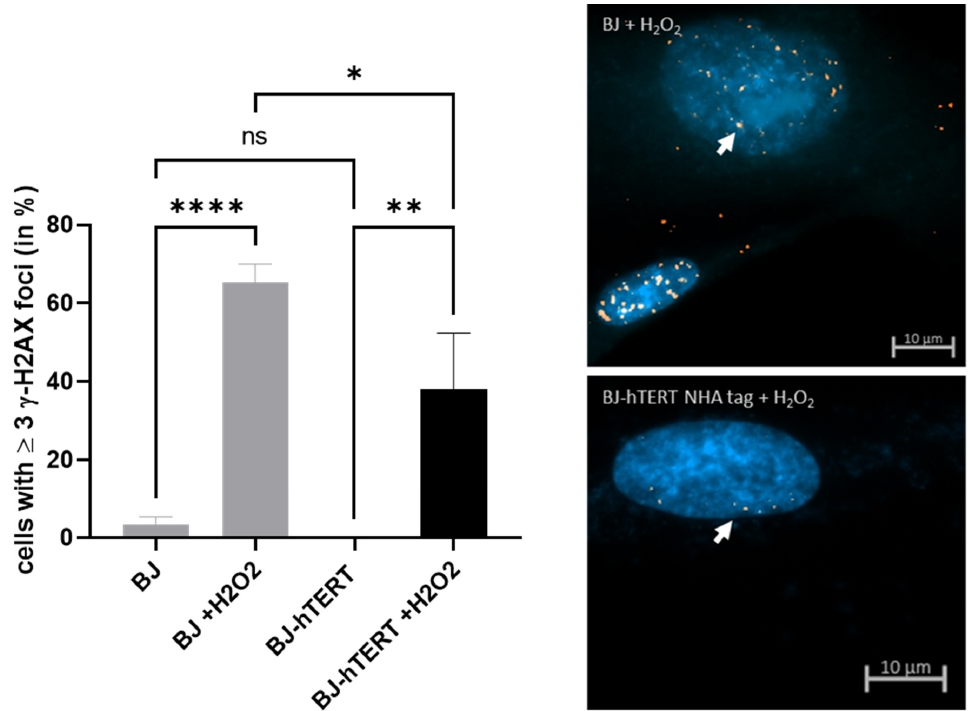
Figure 6. Evaluation of γ -H2AX foci formation upon ROS-induced replication stress. ( Left ) The bar plot displays the impact of H 2 O 2 treatment on γ -H2AX foci formation in BJ and BJ-hTERT cells. One-way ANOVA test was applied, followed by a Fisher’s LSD post hoc test, with a confidence interval of 95%. ( Right ) Representative images from BJ (top) and BJ-hTERT (bottom) treated with H 2 O 2 . A total of 160 cells were counted from n = 4 independent experiments. The representative pictures show DAPI-stained nuclei with nuclear pRPA2 foci (white arrow). ns ( p > 0.05), * ( p ≤ 0.05), ** ( p ≤ 0.01), **** ( p ≤ 0.0001).